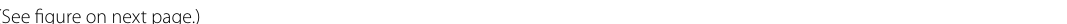
LD‑CM images. Histograms show the subjective + LD‑CM images. Visualization of the abdominal artery, celiac artery, and superior mesenteric artery + no depiction, 2 faint depiction, 3 good depiction, and 4 excellent depiction. The depiction of = = = = not visible, 1 partially visible, 2 partially invisible or slightly irregular appearance, and = = = advanced virtual monoenergetic +